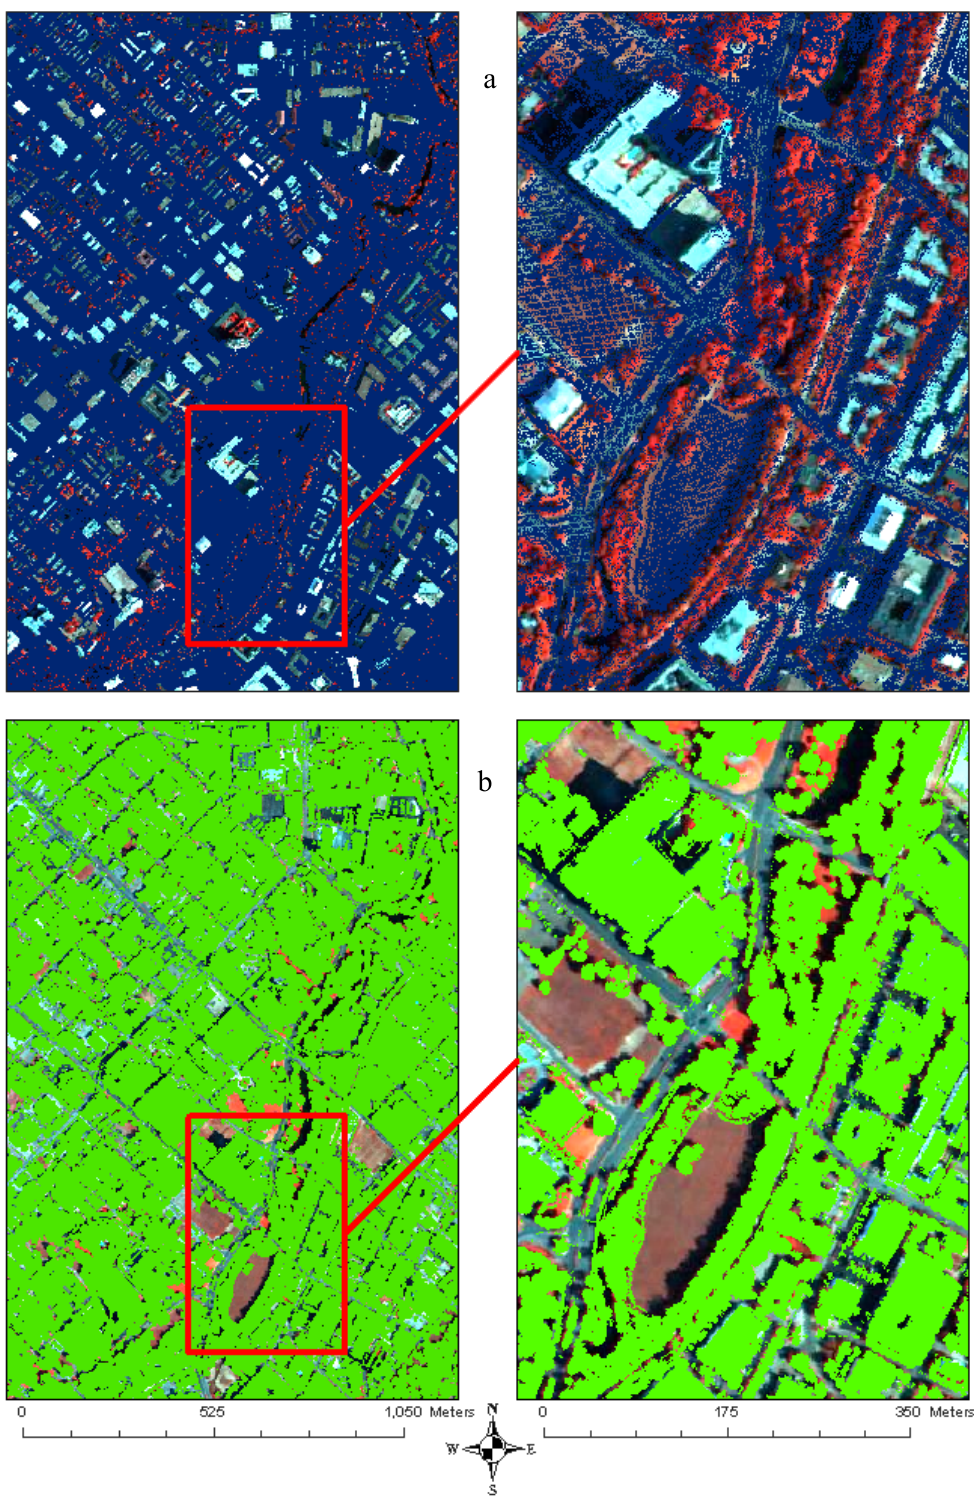
Figure 4. ( a ) Separated ground points in blue dots. ( b ) Separated non-ground points in green dots for the study